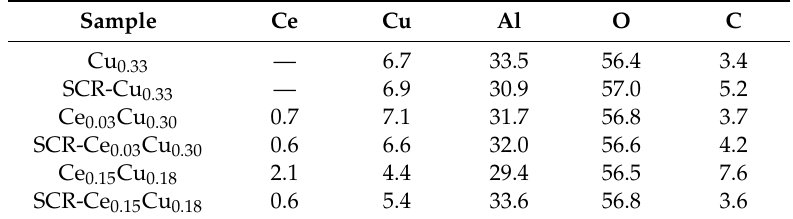
Table 2. XPS Surface composition of cerium doped Cu–Al spinels (at.%).